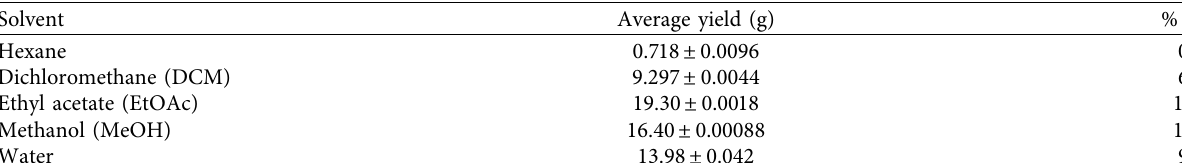
Table 1: Extraction yields of V. glabra roots.